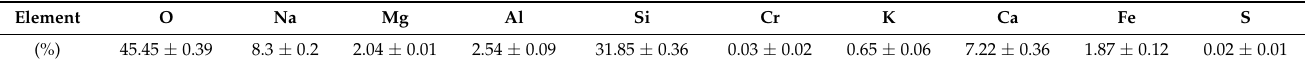
Table 3. Energy-dispersive X-ray spectroscopy (EDS) quantification of glass powder.